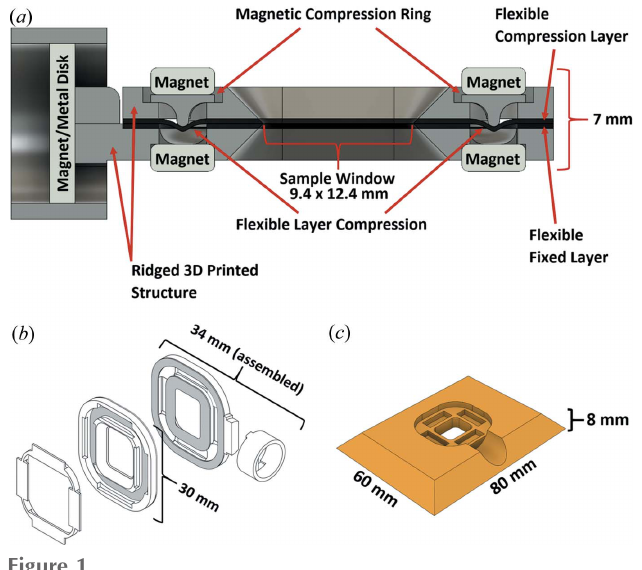
Figure 1 ALEX mesh-holder (larger size). ( a ) Cut-away view of the mesh-holder, ( b ) expanded isometric view (without magnets) and ( c ) isometric view of the mesh-holder loading